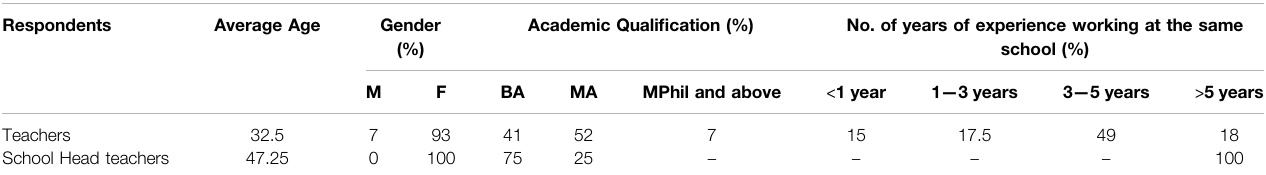
TABLE 2 | Demographic Data for Second Research